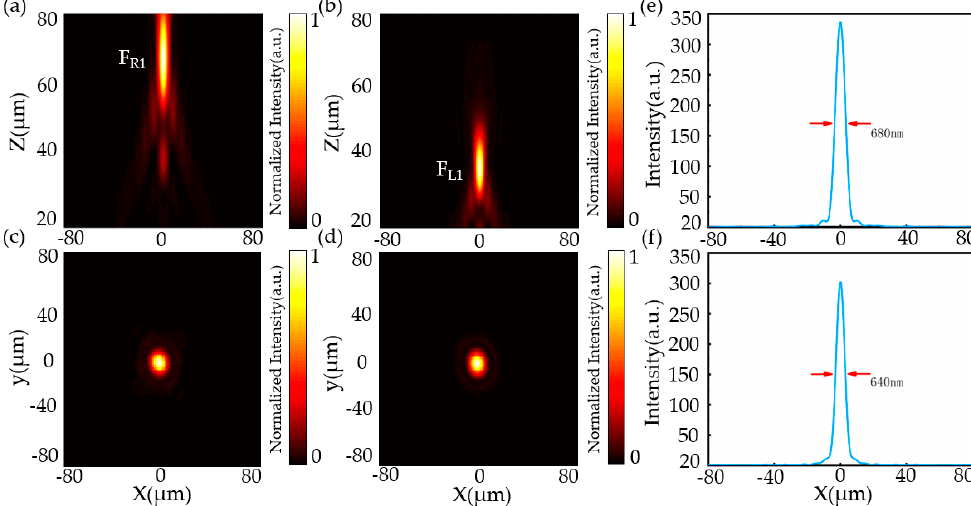
Figure 6. Demonstration of the intensity of the simulated metalens in the x − z and x − y planes under RCP ( a , c ) and LCP ( b , d ) incident light, when the GSSe phase change material is crystalline. ( e , f ) The FWHM values corresponding to the focal spot in ( c ) and ( d ) are 680 nm and 640 nm.